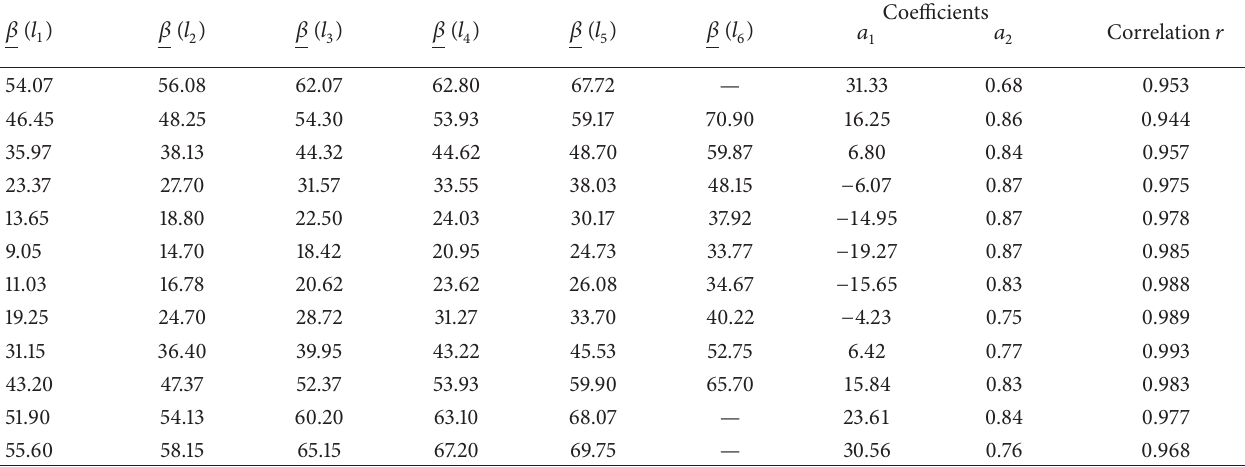
Table 7: The average 𝛽 of the optimum tilt angle values computed using the diffuse solar radiation models, relative to the latitude values used above. A linear regression with 95% confidence interval provided the coefficients 𝑎 1 and 𝑎 2 and the correlation coefficients ranging from 0.944 to 0.993, reported in the last column.